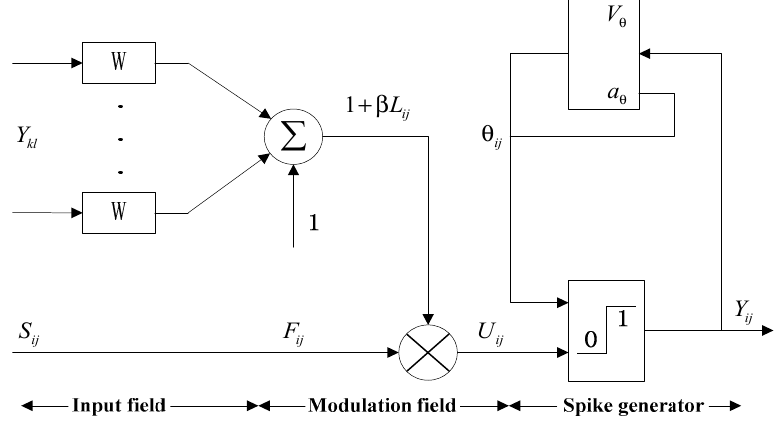
Figure 6. Simplified PCNN model.